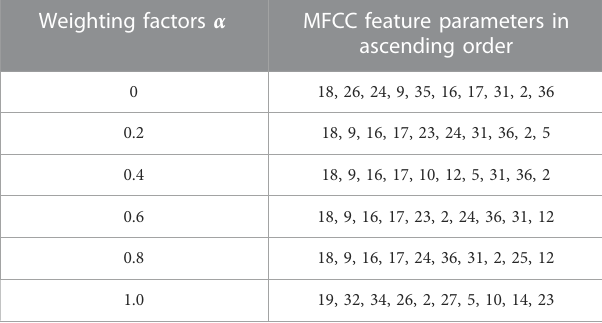
TABLE3AscendingrankingofMFCCcomprehensivecharacteristicparameters. Weighting factors